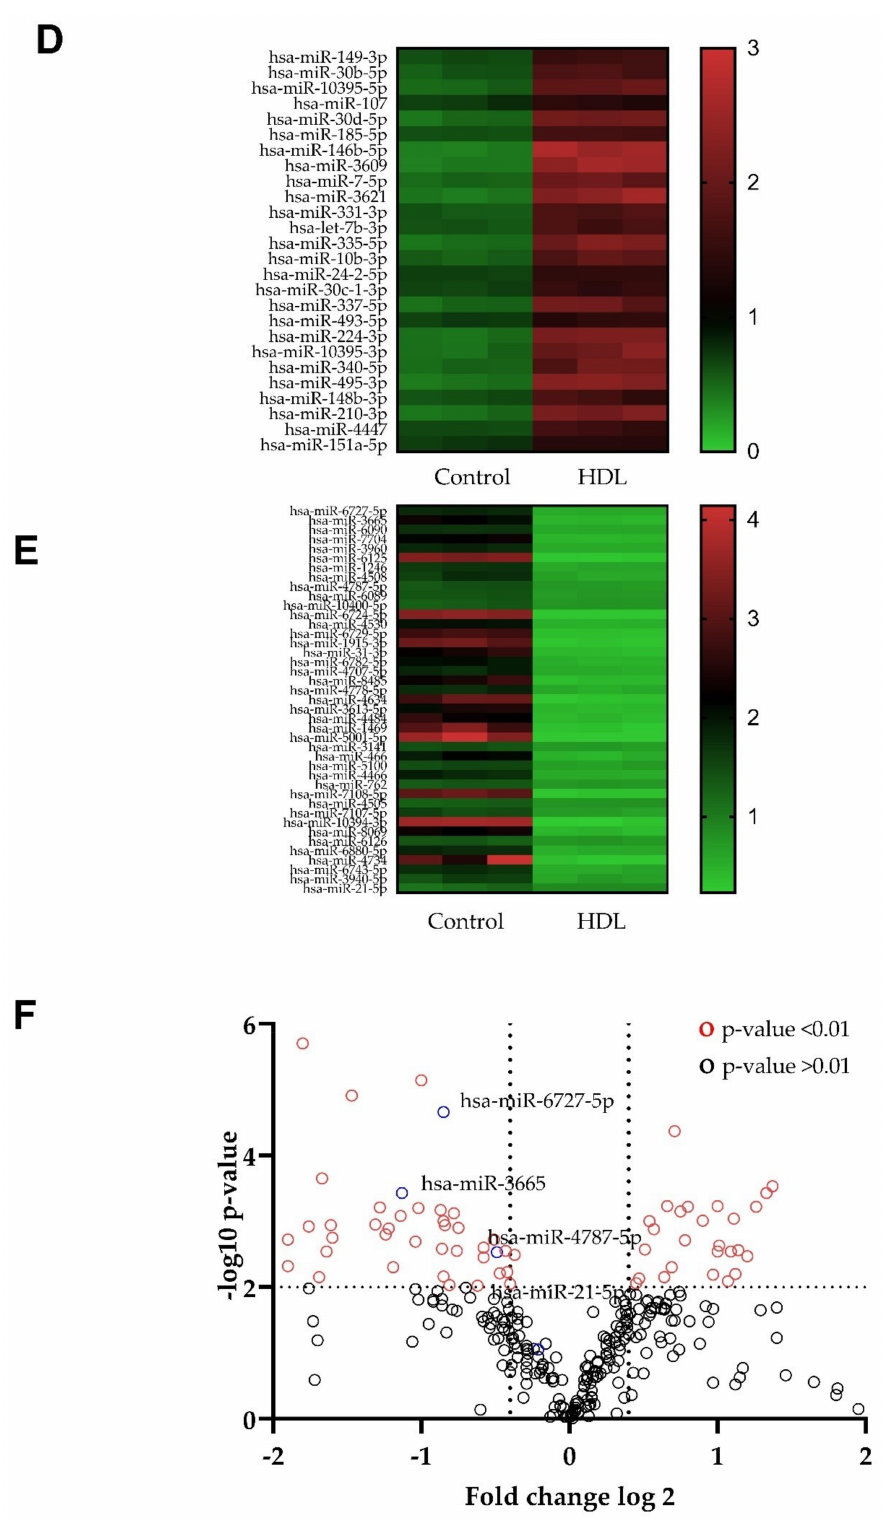
Figure 4. Heatmaps and volcano plots depicting miRNAs regulated following 24 h treatment with 20 µ g ml − 1 HDL, compared with the relevant control, in neonatal human dermal fibroblasts ( A – C ) and adult human dermal fibroblasts ( D – F ). Data are presented from one sample per group, each with an independent microchip array containing three technical replicates per sequence on each microchip. All miRNAs presented show differences p < 0.05 (Student’s t -test) compared to the basal control, and are ranked in order of statistical